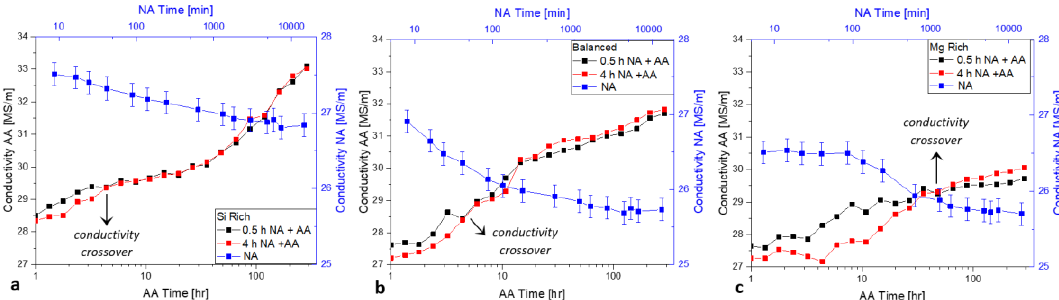
Figure 4. Conductivity evolutions during aging in the high strength Si-rich ( a ); balanced ( b ); and Mg-rich ( c ) alloys after a WQ from ST. The primary axes correspond to AA (175 °C with 0.5 or 4 h prior NA), and the secondary axes correspond to natural aging (NA) itself (~21 °C). Error bars represent 95% confidence. The variation in error is due to the technique in which the measurements were made: Artificially aged samples were all tested in the same sitting, so measurements were not subject to day to day perturbations (e.g., temperature) and uncertainty is simply based off standard error. Naturally aged samples were tested over multiple sittings (i.e., same specimen tested) and uncontrolled variables significantly affected the data. To account for this, each measurement was normalized to that of a pure Al standard; this smoothed the curves but increased the uncertainty (due to the error propagation).